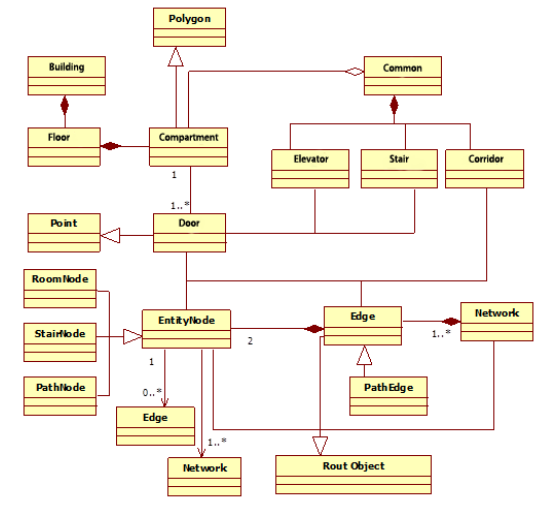
Figure 3 The UML for building space